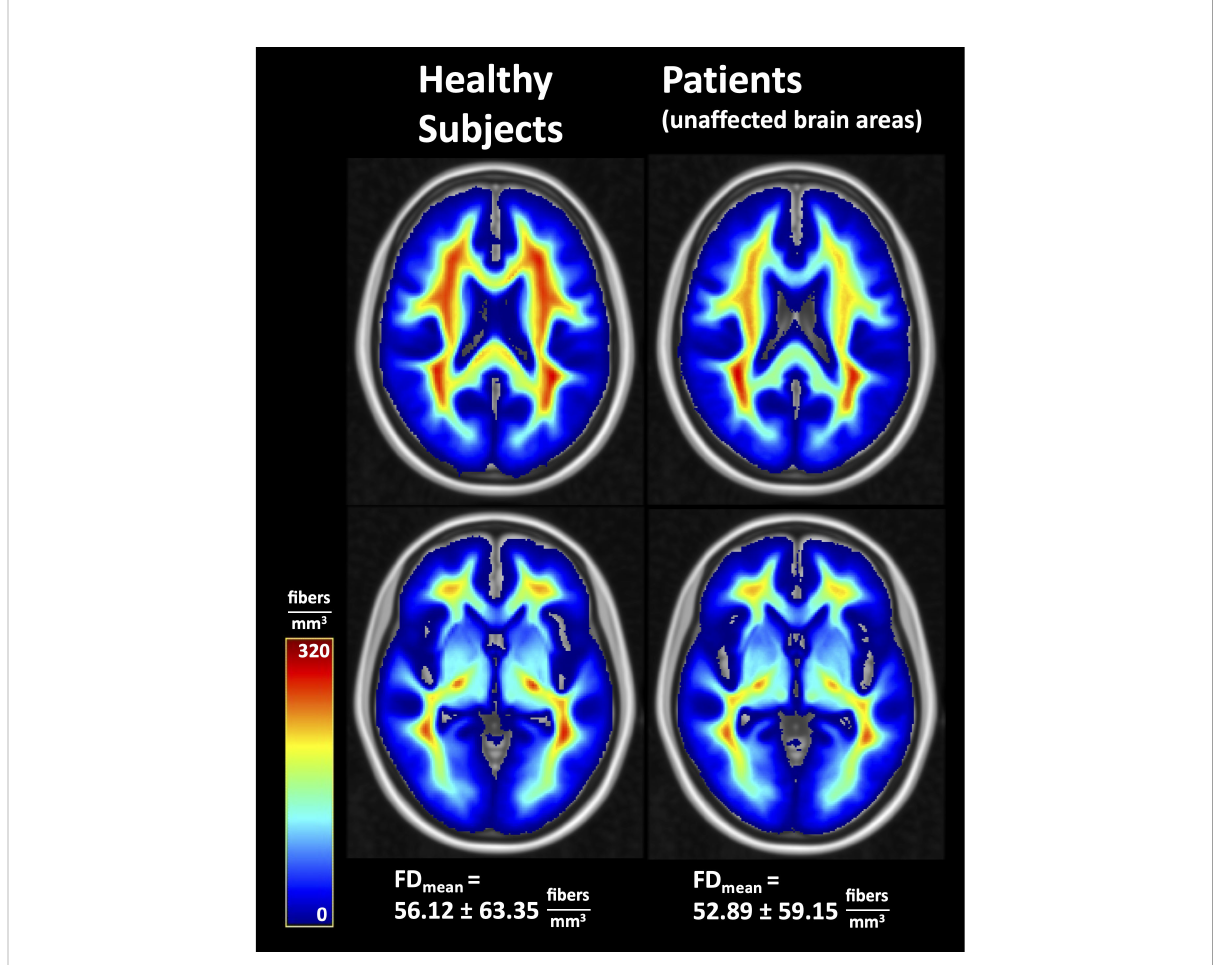
FIGURE 4 Average fi ber densities in healthy subjects and in unaffected brain regions of the patients. FD, fi ber density; FD mean , whole-brain mean fi ber